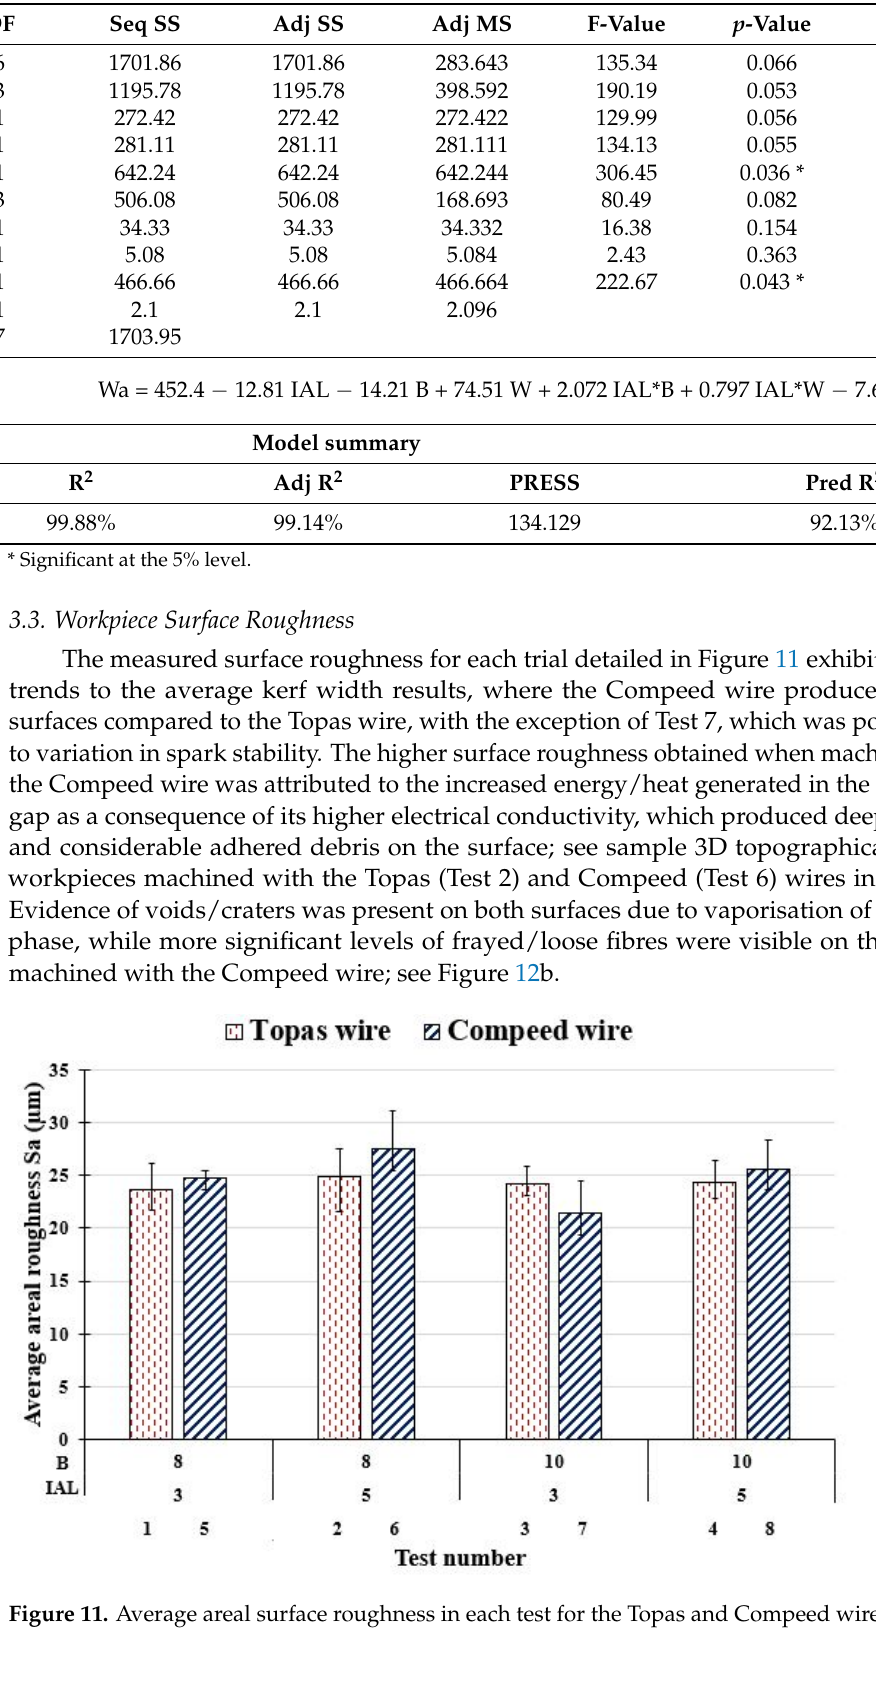
Table 5. ANOVA for average kerf width including interactions.